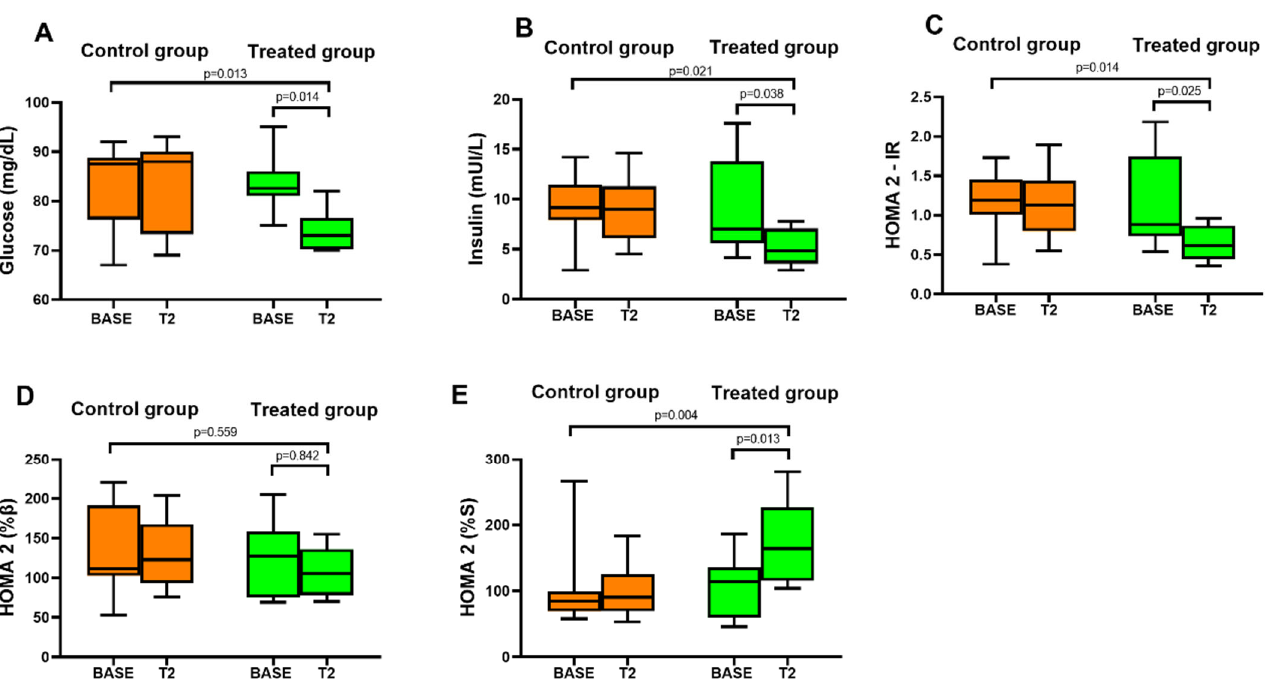
Figure 2. Markers of glucose metabolism measured at baseline (BASE) and after 12 days of lettuce consumption in the control group and in the treated group. ( A ) Box and whisker plot of fasting glucose. ( B ) Box and whisker plot of fasting insulin. ( C ) Box and whisker plot of insulin resistance. ( D ) Box and whisker plot of β‐ cell function. ( E ) Box and whisker plot of insulin sensitivity.